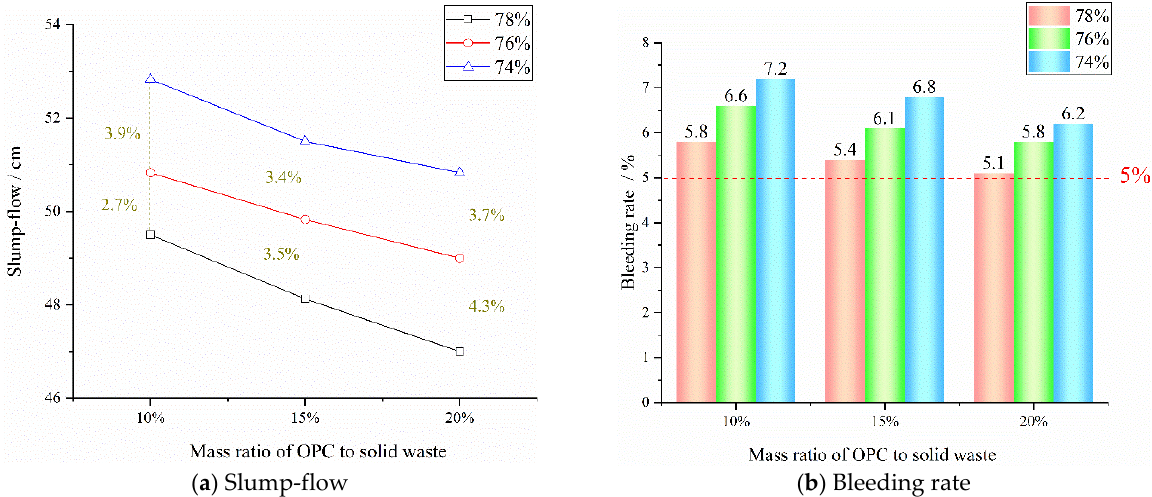
Figure 8. Test results of slump-flow and bleeding rate of backfill materials with different mass concentrations and OPC-mass ratios.